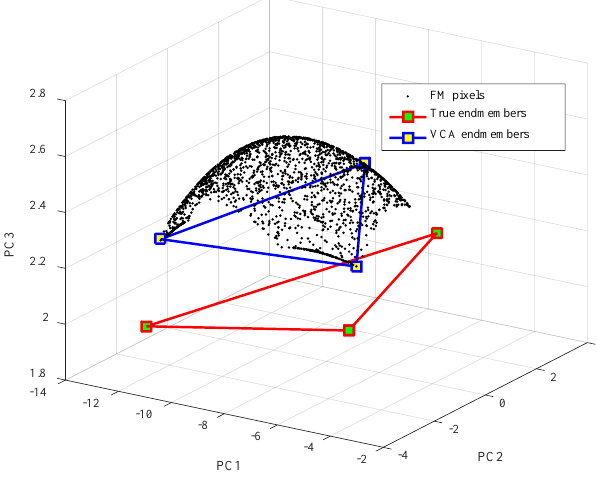
Figure 5. Endmember extraction for highly-mixed FM data.